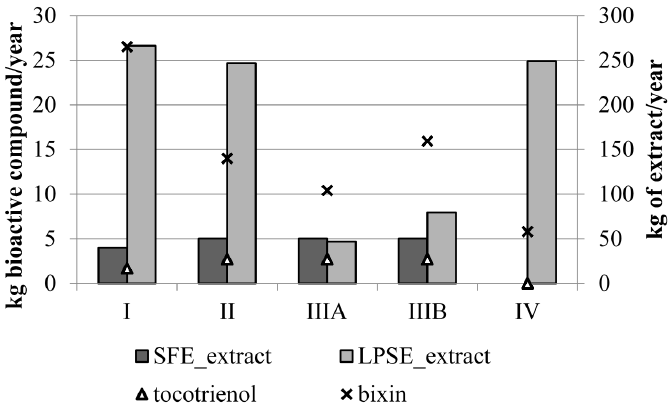
Figure 2. Productivity of SFE extract, LPSE extract, tocotrienols and bixin for the evaluated annatto seeds-sugarcane biorefinery configurations.